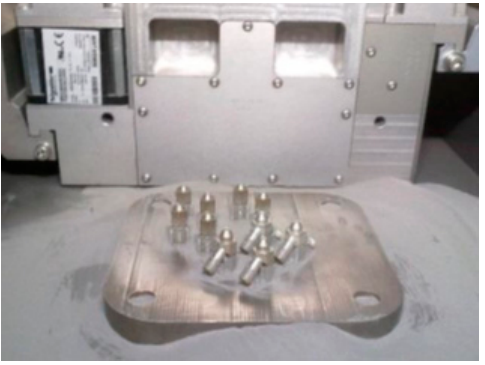
Figure 4. Components produced by SLM prior to performing the post-processing.